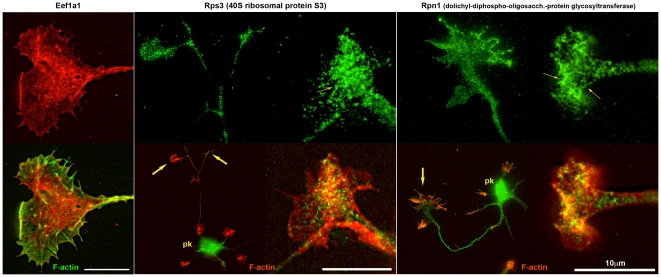
Hippocampal pyramidal neurons and/or their axonal growth cones labeled with antibodies to proteins involved in protein synthesis (top row).The antibody specificities are indicated above. Dual-fluorescence images including labeling for filamentous actin are shown in the bottom row. pk, neuronal perikaryon; large arrows, axonal growth cones; small arrows, reticular structures.